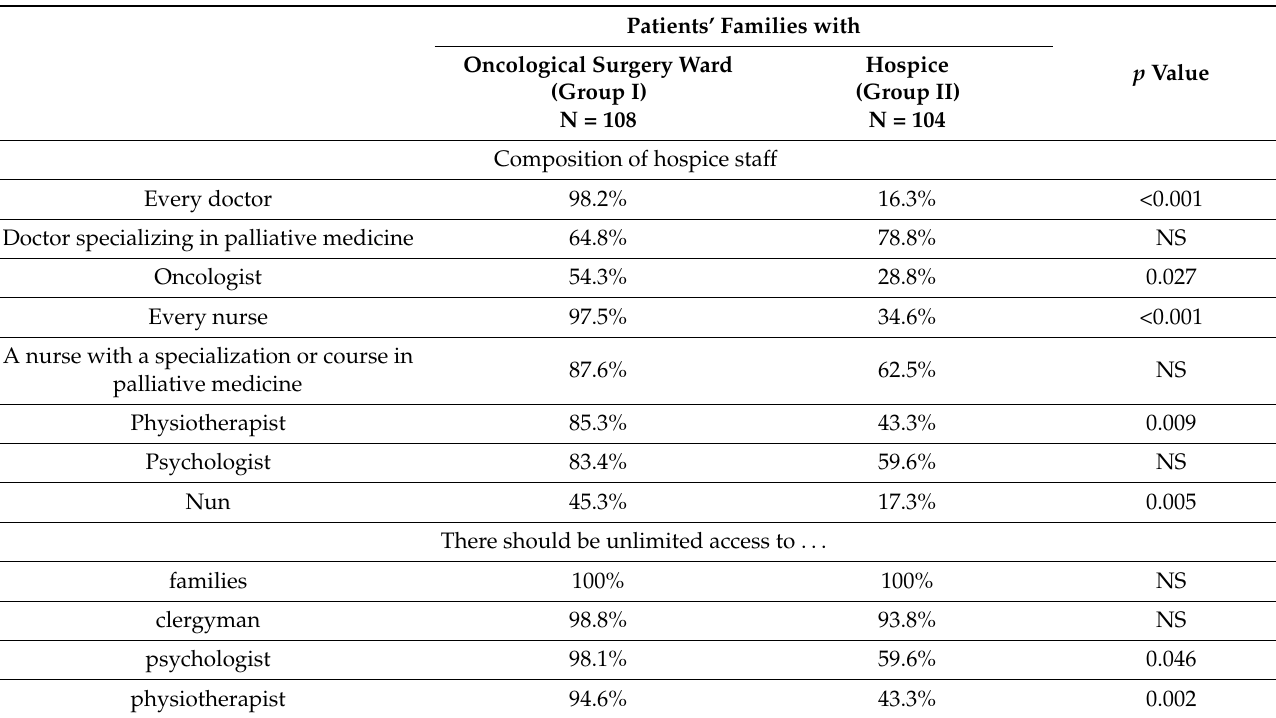
Table 8. The respondents’ opinions about the hospice staff *.